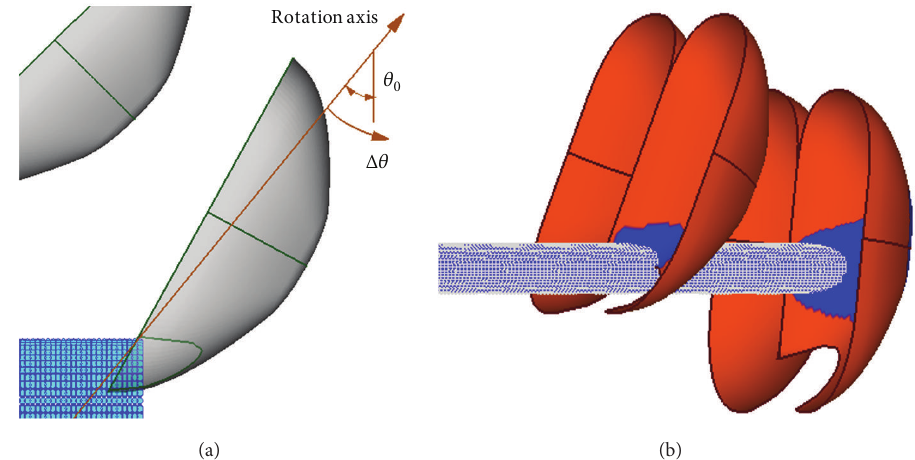
Figure 1: FLS modeling: jet discretization and jet-bucket interaction starting angle (a); surface flow simulation and representation (b).